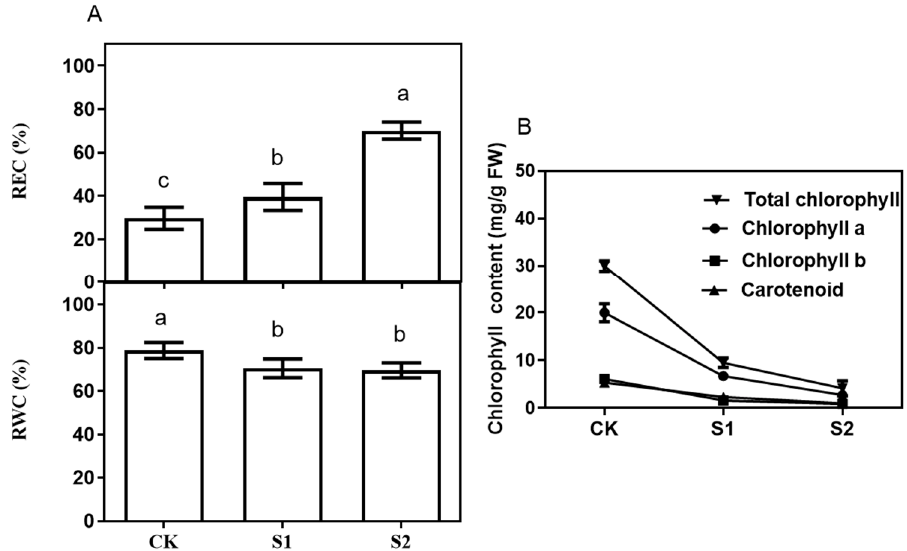
Figure 1. Effect of different concentrations of NaCl on ( A ) relative electrical conductivity (REC) and relative water content (RWC) in leaves of G. sinensis seedlings. REC and RWC were analyzed immediately after one week of treatment. ( B ) Photosynthetic pigments in leaves of G. sinensis . Photosynthetic pigments were analyzed immediately after treatment of the leaves at the same position in the plant one week later. CK represents G. sinensis leaves in normal hydroponic growth in Hogland nutrient solution, and S1 and S2 are G. sinensis leaves treated with concentrations of 100 and 200 mmol/L NaCl, respectively. The data are the average SD of three independent replicates. The mean values represented by the different letters were significantly different in Tukey’s test at p < 0.05.